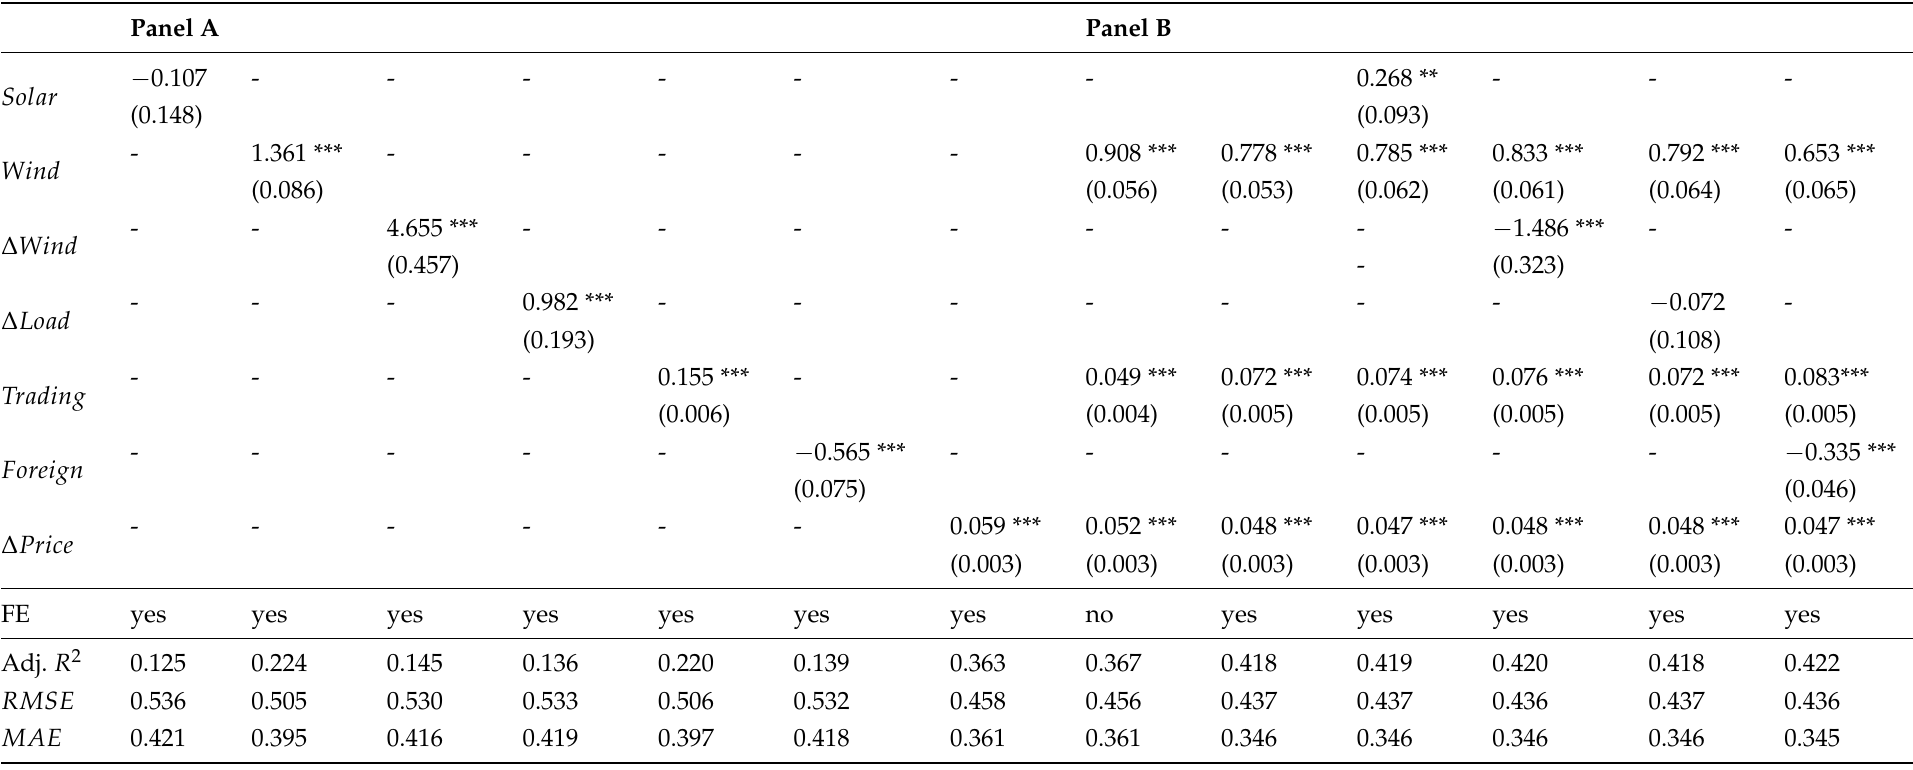
Table 5. Regression results for the volume-weighted average standard deviation VSD as dependent variable for different models. Panel A contains the coefficients of univariate regressions with additional fixed effects for contracts, day, season, year, daylight saving time, and the possibility of control zone trading later. Panel B contains the coefficients of different multivariate regression designs. Solar is the relative solar share of the total consumption, Wind is the relative wind share of the total consumption, and ∆ Wind is the relative solar forecast error of the total consumption. ∆ Load is the unsigned relative excess generation over consumption in Germany, Trading is the traded volume of the intraday market in GWh, Foreign is the relative share of the volume (buy and sell) traded between Germany and a foreign country and the total traded volume of the intraday market, and ∆ Price is the absolute price difference of the day-ahead auction price and the volume-weighted average intraday price. FE denotes fixed effects. RMSE is the root mean squared error and MAE is the mean absolute error. The asterisks denote the significance level with *** = 0.1% and ** =